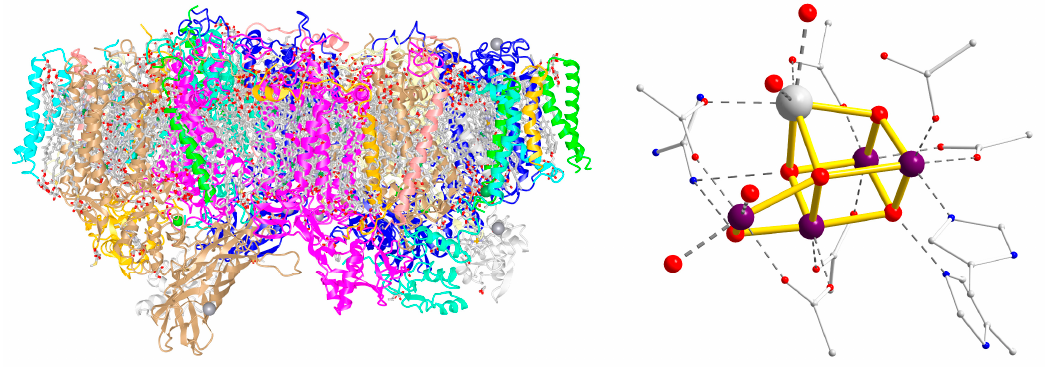
Figure 1. Overall structure (left) and Mn 4 CaO 4 site (right) in PSII (PDB code 3WU2). Colour scheme: Mn, violet; Ca, grey; O, red; N, blue; C, grey (small balls). M–O–M bonds are highlighted by yellow.